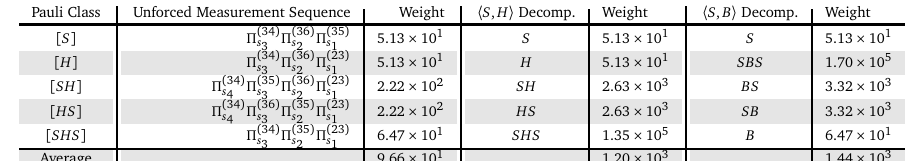
Table 14: Minimal difficulty weight measurement sequences for each Pauli coset of single-qubit Clifford gates when using Majorana-Pauli tracking methods. For comparison, we also present the corresponding realization of the gates formed by using the generating gate sets 〈 S , H 〉 and 〈 S , B 〉 .